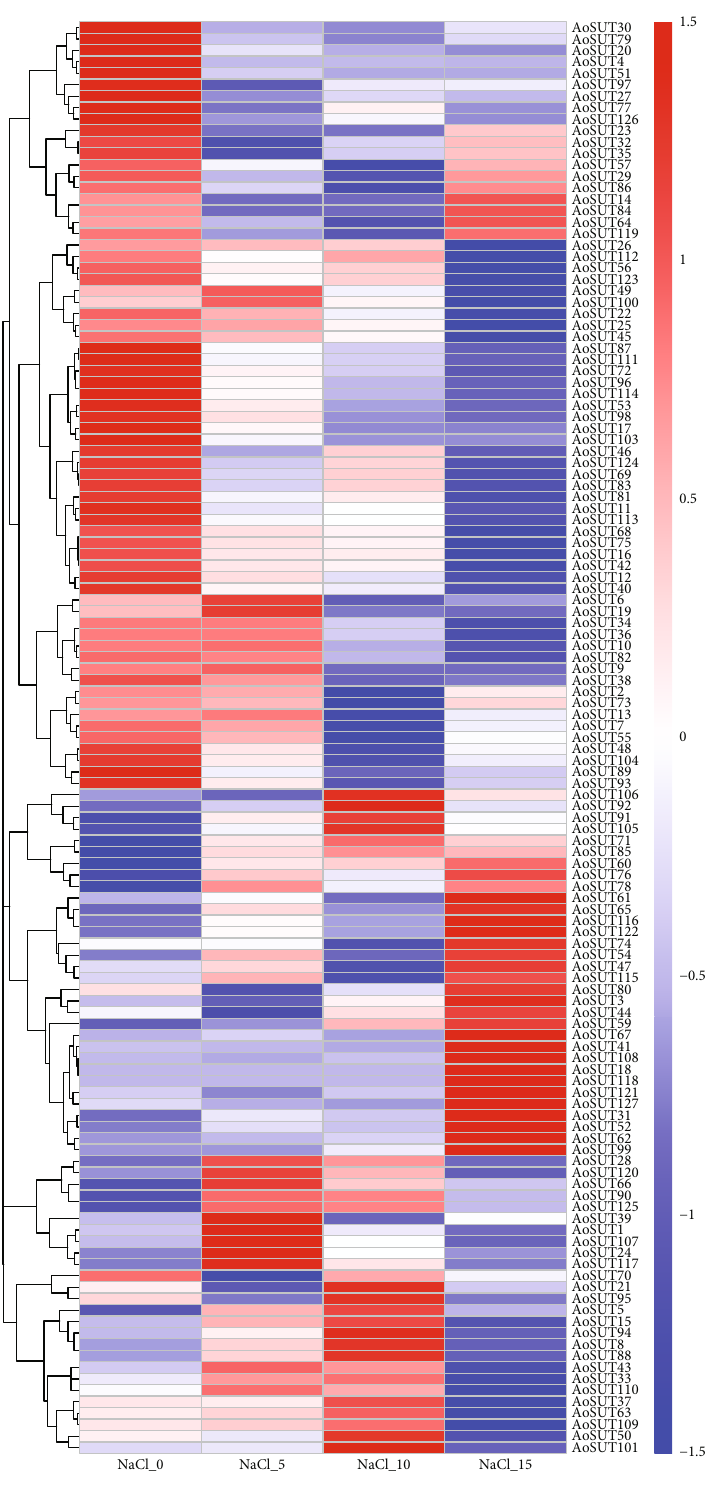
Figure 6: The expression levels of AoSUT genes under salt stress. NaCl_0_5_10_15 indicated samples cultivated in PDA medium supplied with 0, 5, 10, and 15% NaCl, respectively. The color scale bar, ranging from blue to red, represents low and high expressions,